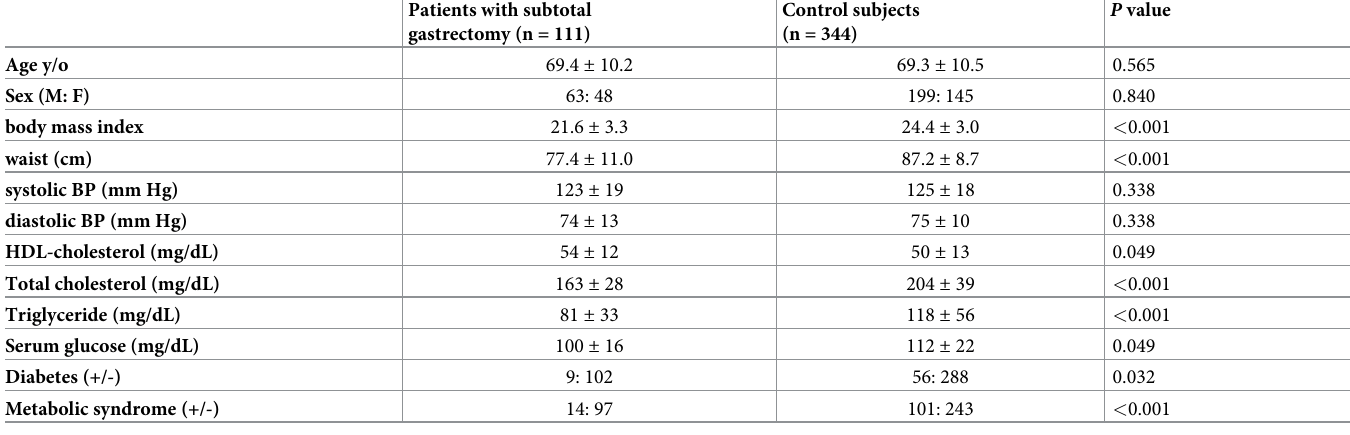
Table 1. Anthropometric and laboratory data between patients with subtotal gastrectomy (Billroth II anastomosis and Roux-en Y gastrojejunal anastomosis) and patients without gastric surgery with a median follow-up of 8.25 years. Patients with subtotal Control subjects gastrectomy (n = 111) (n =